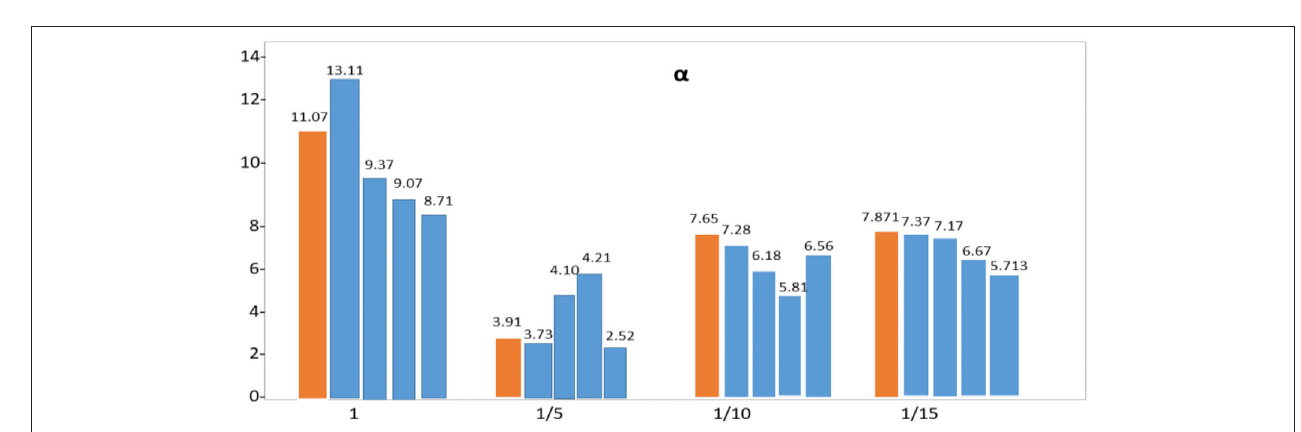
FIGURE 8 | Tuning of SIER model parameter.